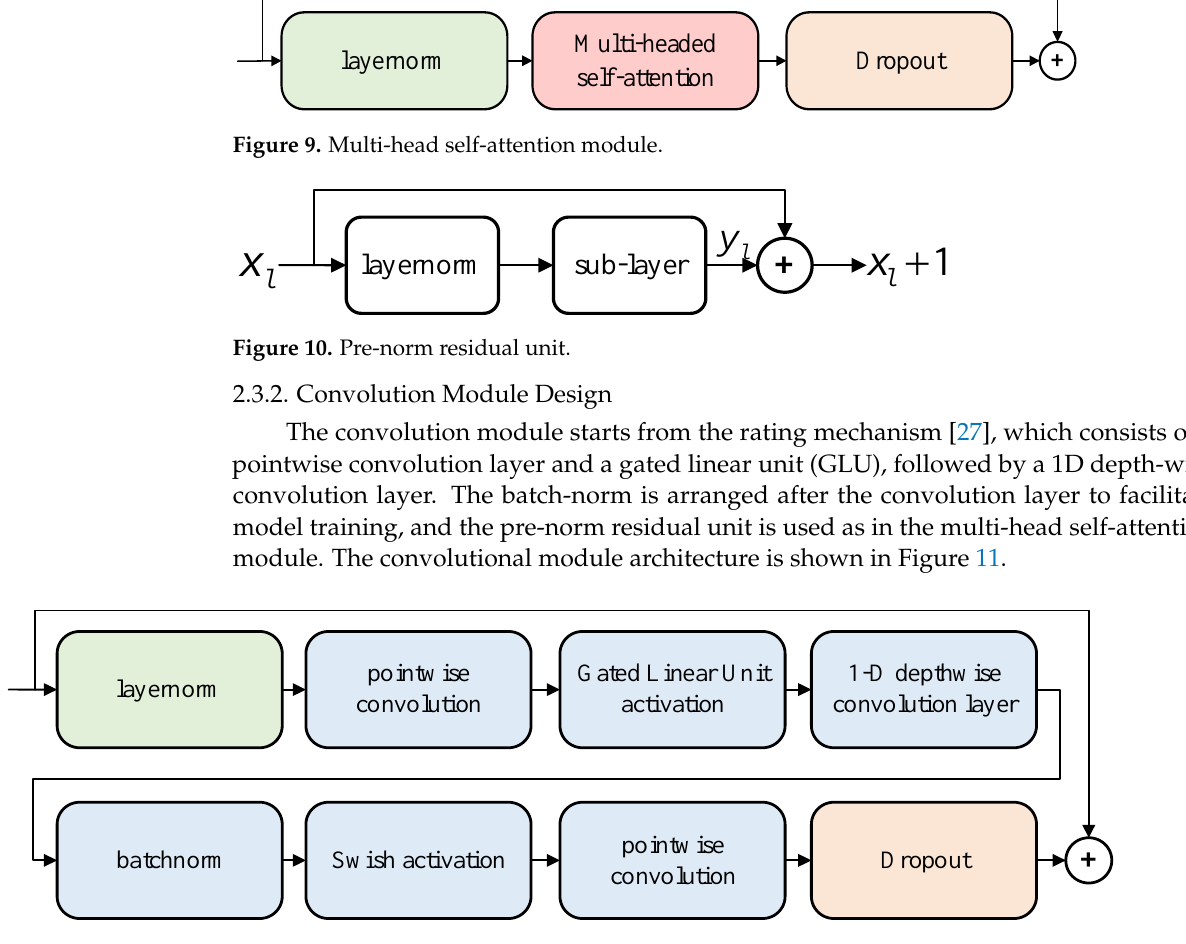
Figure 11. Convolution module.